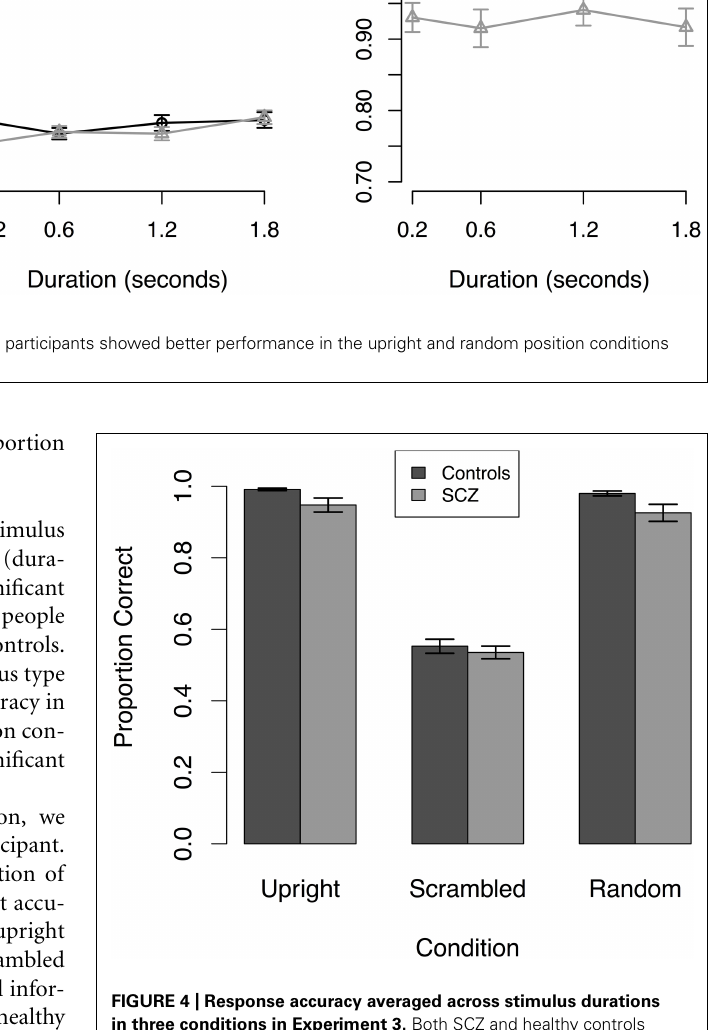
FIGURE 4 | Response accuracy averaged across stimulus durations in three conditions in Experiment 3. Both SCZ and healthy controls performed significantly worse in the scrambled condition compared to the upright and random position conditions. Results shown are collapsed across all stimulus